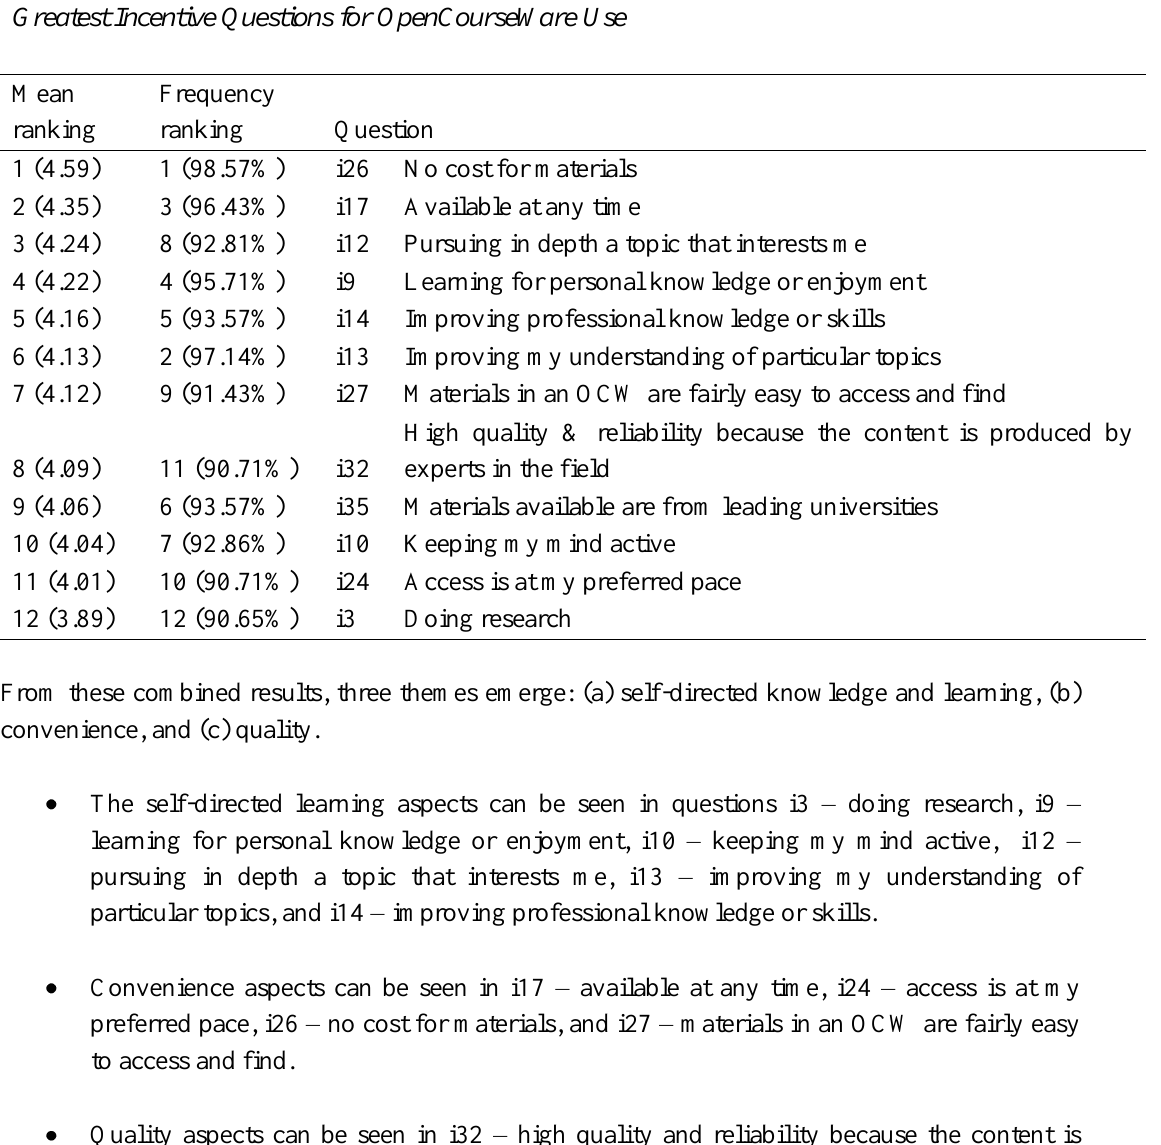
Greatest Incentive Questions for OpenCourseWare